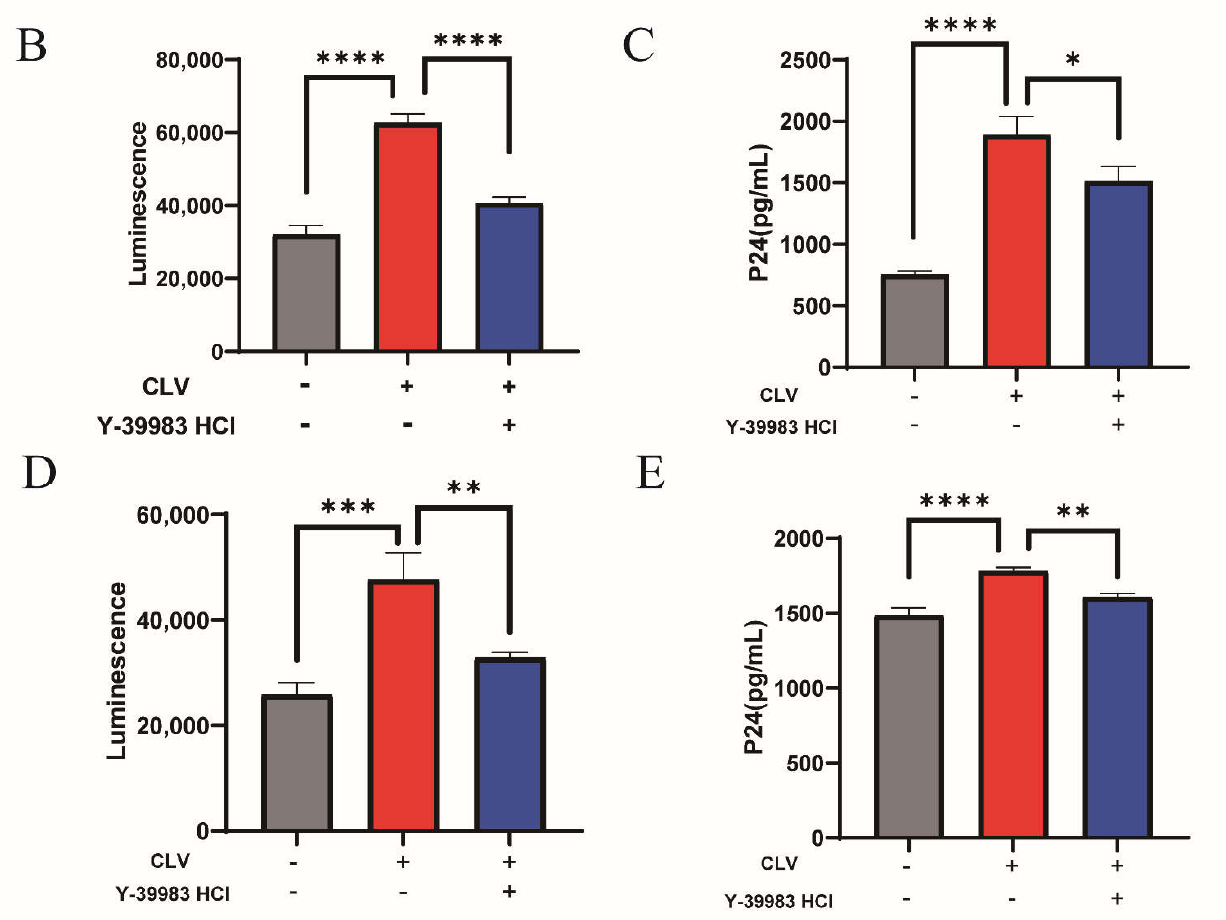
Figure 4. Y-39983 HCl reduced HIV-1 particle release. HEK293T cells were co-transfected with CLV-NSB plasmid or empty LgBiT vector (CLG)-NSB. Four hours after transfection, the cells were co-transfected with HIV Env expression plasmid pREJO4541.67 and backbone vector pSG3∆env in the presence of Y-39983 HCl. After 2 days, cells were lysed to detect Vpu expression by Western blotting ( A ). Env-pseudotyped virions were collected from the supernatant and used to infect TZM-bl cells. Two days after infection, the cells were lysed to evaluate luciferase activity using Bright-Glo Luciferase Assay System ( B ) and the supernatant was collected for p24 detection using ELISA assay ( C ). ( D ) HeLa cells were transfected with plasmid CLV or CLG. After 4 h, cells were co-transfected with HIV Env expression plasmid pREJO4541.67 and backbone vector pSG3∆env in the presence of Y-39983 HCl. Virions were collected from the supernatant and quantitated using TZM-bl assay. The luciferase activity was measured using Bright-Glo Luciferase Assay System. The supernatant of TZM-bl culture were collected for HIV-1 p24 detection using ELISA assay ( E ). ns, Not Significant; *, p < 0.05; **, p < 0.01; ***, p < 0.001; ****, p < 0.0001 vs. Vpu group. Values presented are the mean ± SD. All experiments were repeated thrice.